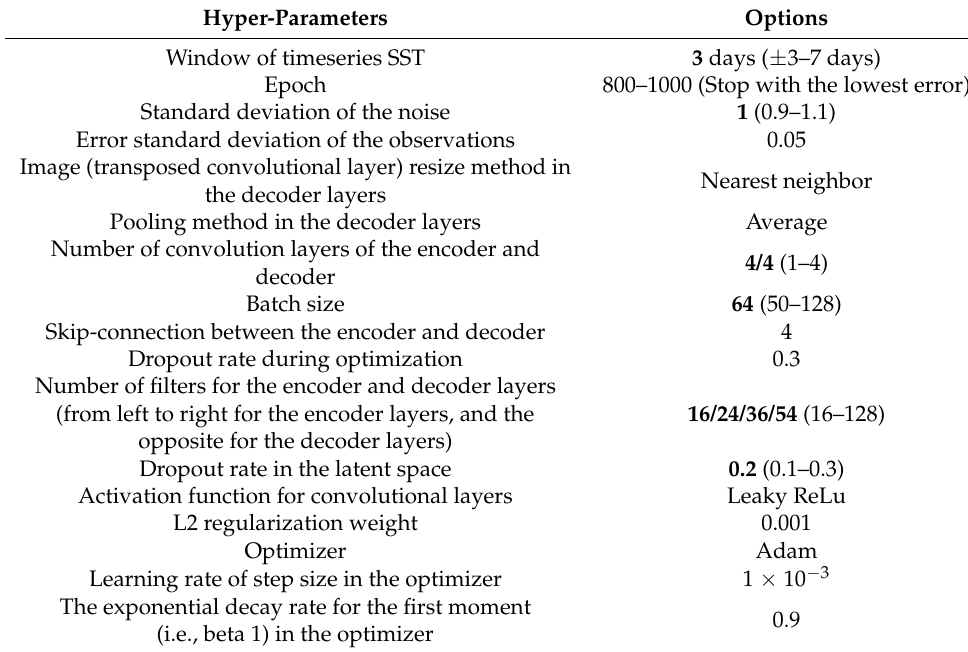
Table 2. The hyperparameters used to train DINCAE in this study. The values in bold indicate the optimized (selected) hyperparameter values. The range of numerical values in the parentheses was empirically tested for parameter